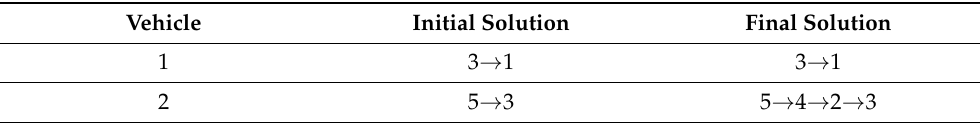
Table A3. The initial and final solutions of greedy